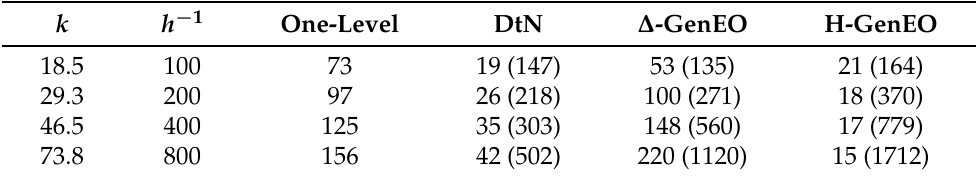
Table 1. Preconditioned GMRES iteration counts and size of coarse space (in parentheses) for the homogeneous problem when using ORAS and various coarse spaces. A uniform decomposition into 5 × 5 square subdomains is used, giving 25 subdomains in